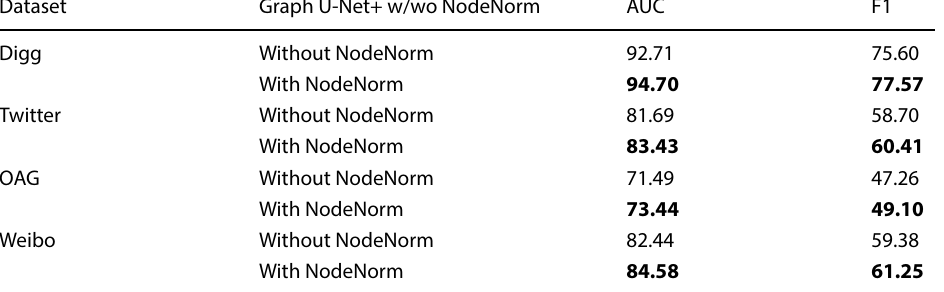
Table 8 Social behavior prediction performance of graph U-Net+ with or without deep supervision mechanism on AUC and F1 metrics ( %